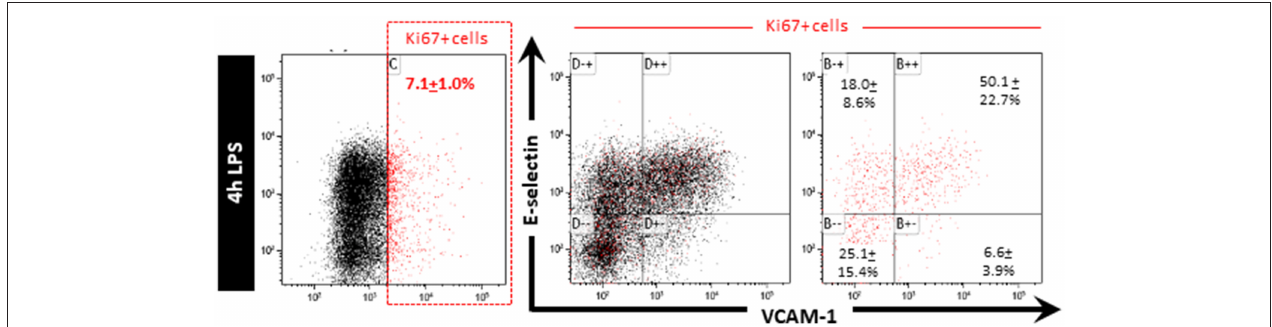
FIGURE 3 | Cell division is not a major factor controlling the ability of EC to express E-selectin and/or VCAM-1 when exposed to LPS. HUVEC exposed to LPS for 4h were stained for Ki67 after which Ki67 positive cells were gated and the extent of E-selectin and VCAM-1 expression on those cells determined. Ki67 positive cells are indicated in red. The percentage of Ki67 positive cells expressing different extents of E-selectin and VCAM-1 is reported as the mean ± SD of three independent